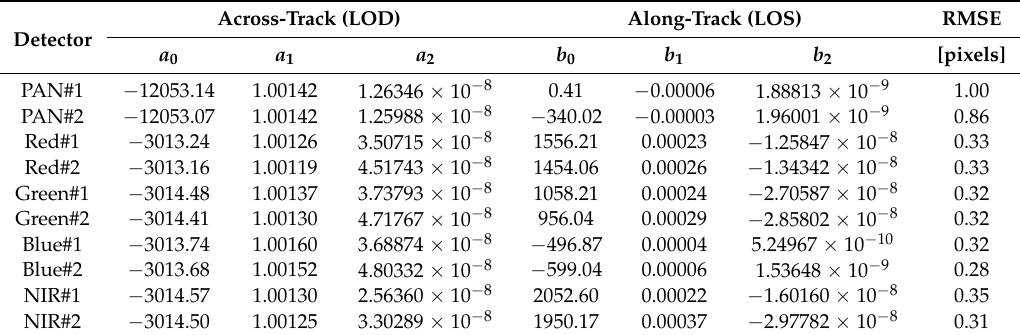
Table 3. Determined alignment parameters for each